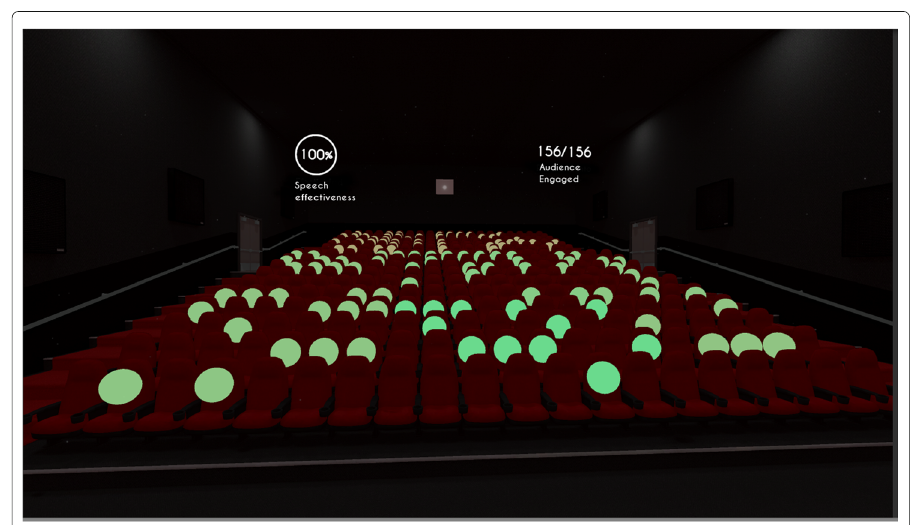
Fig. 1 Game environment. Screen capture of the game